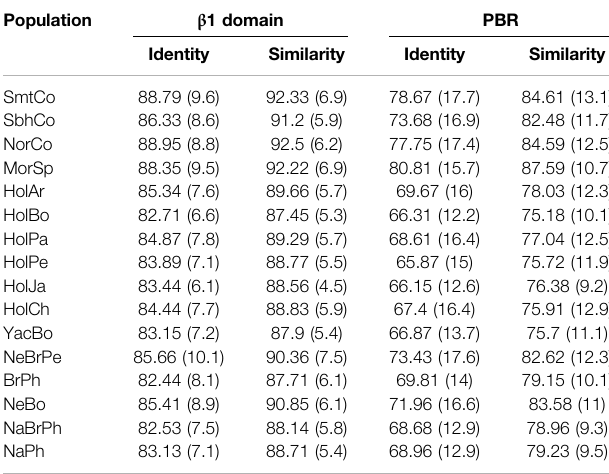
TABLE 4 | Genetic diversity at sequence level within cattle populations.